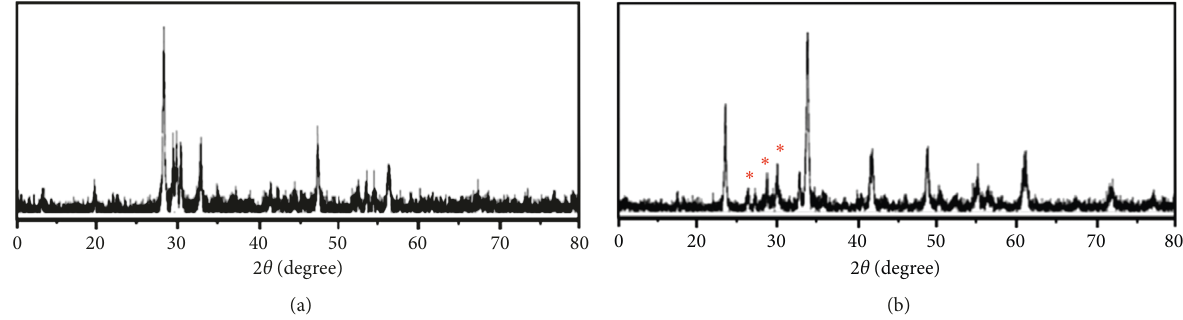
Figure 2: X-ray diffraction patterns of products obtained from sol-gel processing using (a) Gd(CH Al(NO 3 ) 3 · 9H 2 O. The impurity phases are marked.